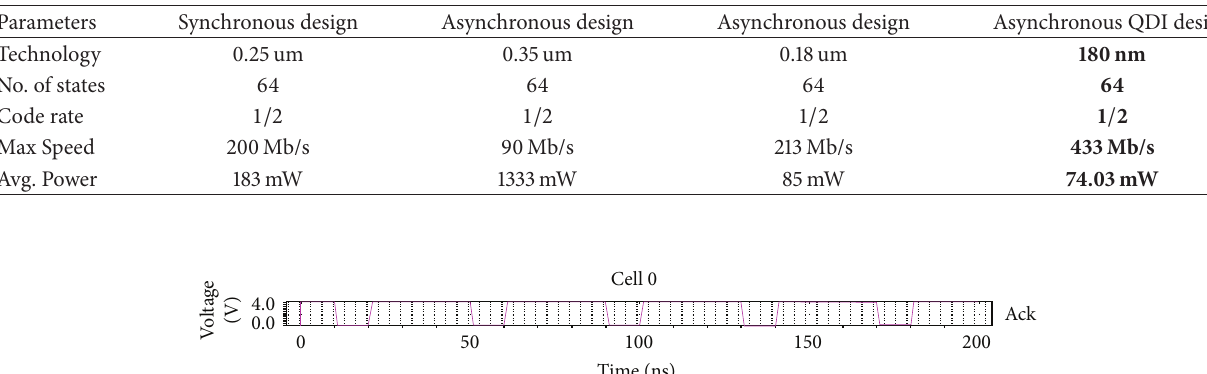
Table 3: Comparison of parameters of Asynchronous Viterbi decoder with the state of art from existing designs [19].